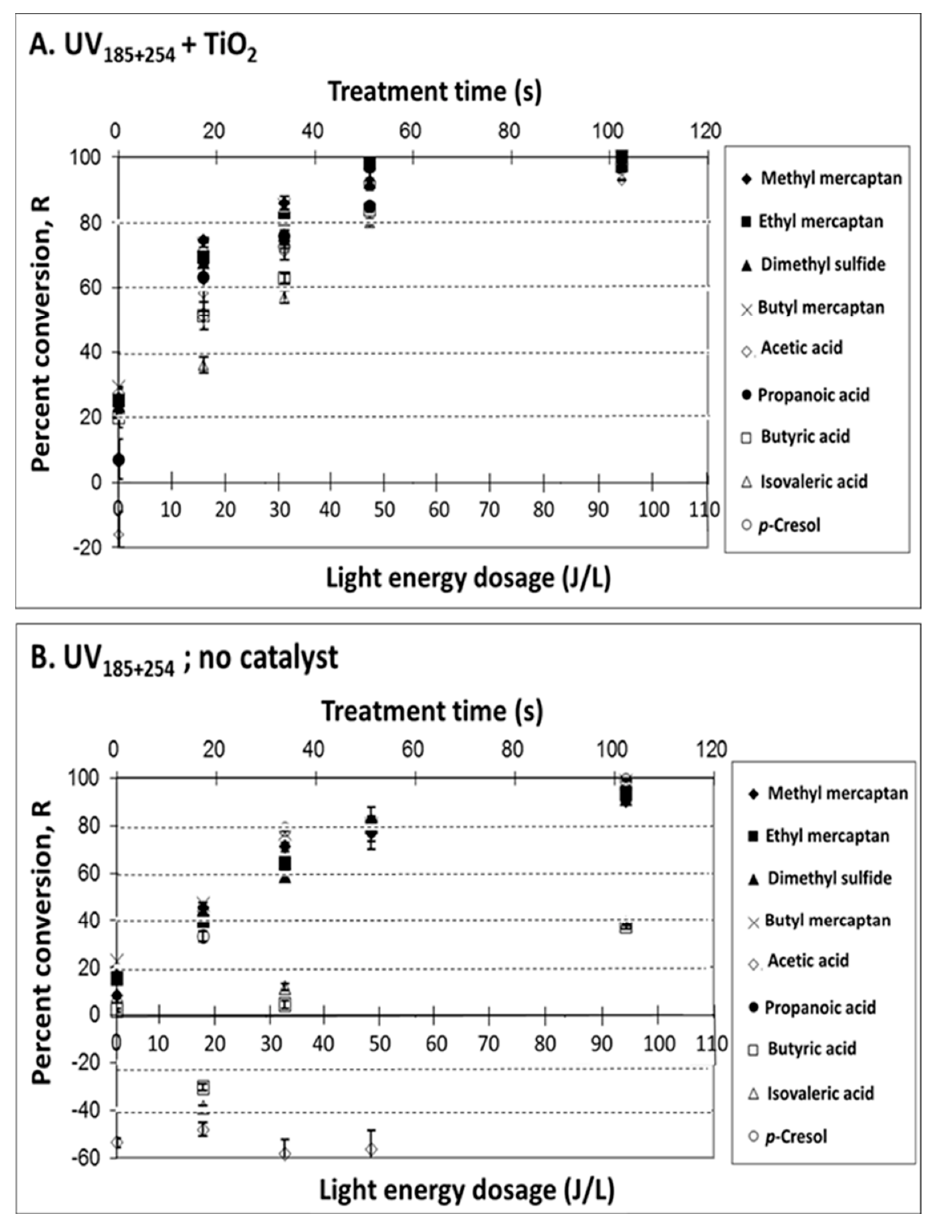
(Figure 1A: UV 185 + 254 + TiO 2 vs. Figure 1B: UV 185 + 254 , no catalyst) and at 254 nm (Figure 2A: UV 254 + TiO 2 vs. Figure 2B: UV 254 , no catalyst). Positive R values indicate VOC removal, whereas negative values indicate the formation of target VOCs, presumably as intermediate byproducts during photodegradation of parent compounds [44]. Supporting data for Figures 1 and 2, including measured gas concentrations, % VOC conversion, and VOC mass removed per unit of UV energy input (ng J − 1 ) are presented in Tables S1–S4.